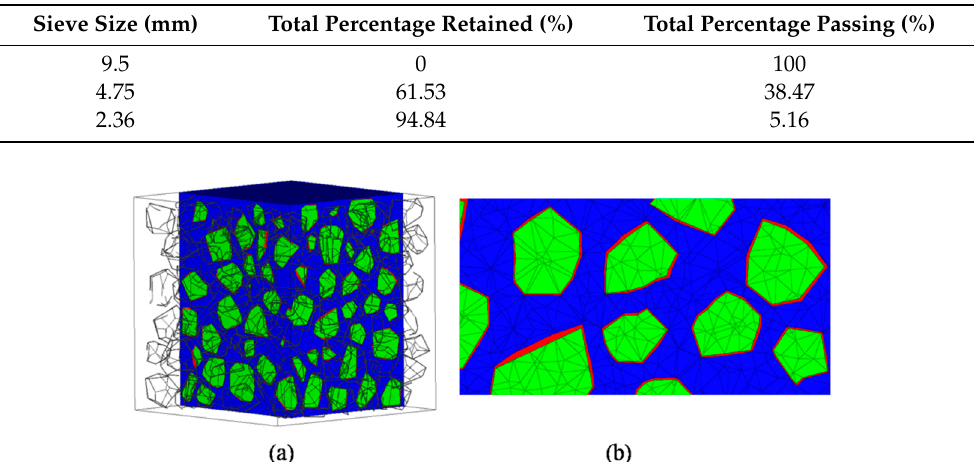
Figure 14. 3D skeleton diagram ( a ) and schematics of sample specimen ( b ) for uniaxial quasi-static simulation. 4. 3D Mesoscale Simulations 4.1. Concrete Damaged Plasticity Model The behavior of concrete is complex due to an array of morphological features as well as deformation and failure mechanisms inherent in the concrete microstructure. In recent years, many coupled plasticity–damage models have been proposed to describe the mechanical behavior of concrete [44–46]. The model included in the ABAQUS package (Dassault Systèmes Simulia Corp., Providence, RI, USA) called concrete damaged plasticity (CDP) has been widely used for the description of static and dynamic mechanical behaviors of concrete-like materials. The model assumes that the uniaxial compressive and tensile responses of concrete are characterized by damaged plasticity. The typical stress–stain curve is shown in Figure 15 and the stress–strain relationships under compression and tension are